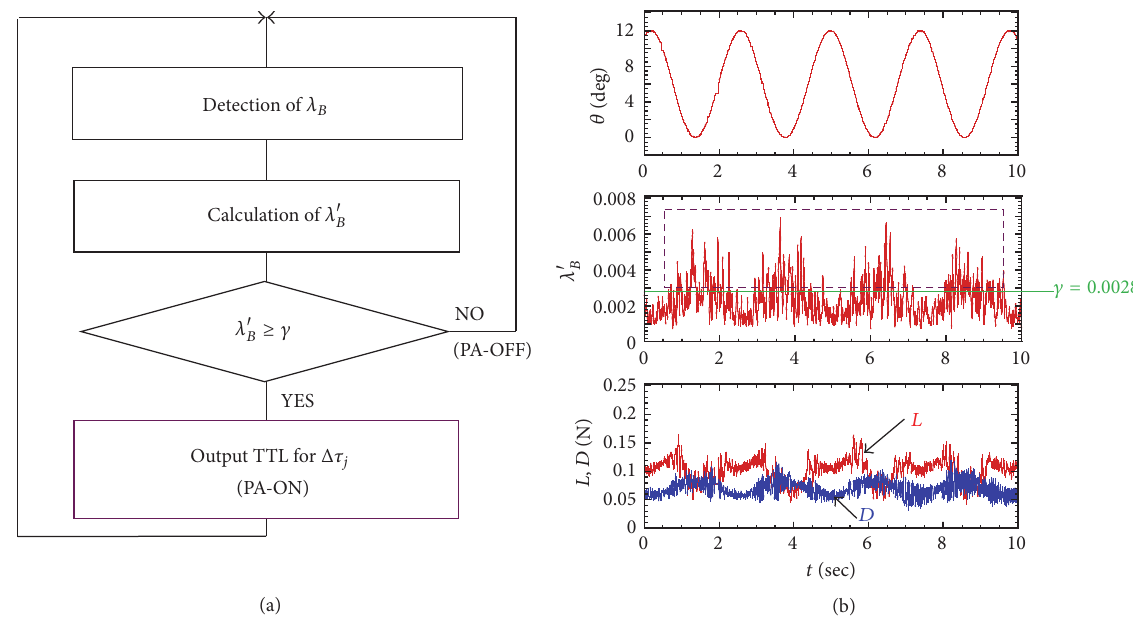
Figure 12: (a) Flowchart for the closed-loop control of flow separation. (b) 𝜃 time-series, running 𝜆 󸀠 𝐵 , 𝐿 , and 𝐷 fluctuations for 10s. The running 𝜆 󸀠 𝐵 at a given time was evaluated using the past 50 values for 𝜆 𝐵 . Flow separation occurs in the region of 𝜃 ≤ 4 ∘ when the running 𝛾 = 0.0028 𝜆 󸀠 𝐵 is larger than